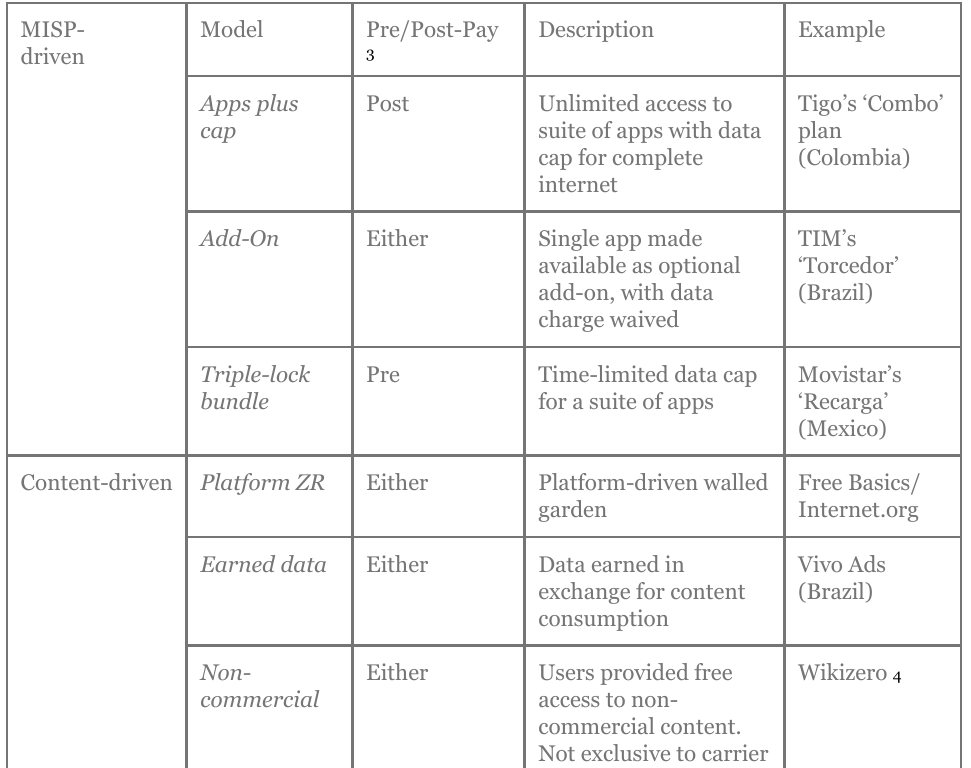
Table 1: Typology of forms of zero – and Near-0 – rated data offers in the global